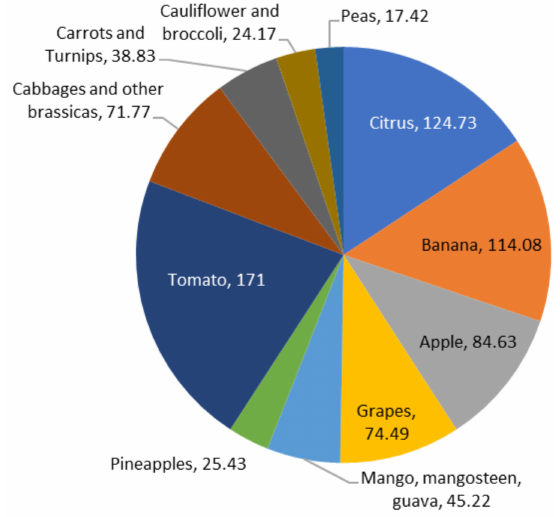
Figure 2. A significant amount of fruits and vegetables (in MMT) are produced globally. FVW is generated in large quantities in open markets, but little information is avail- able on the actual volume of waste generated. Since significant amounts of waste are produced by the fruit and vegetable value chains, biorefinery concepts have been de- veloped to valorize these wastes [23]. Waste from the FVW can be reused or recycled, which is more environmentally beneficial than disposal through open dumpsites or in- cineration [24]. Wholesale marketplaces, supermarkets, and agricultural activities are the traditional sources of FVW. Fruits and vegetables produce FVW at every stage of the chain, including production, transportation, storage, distribution, and consumption [25]. The valorization of FVW and potential products are shown in Figure 3.